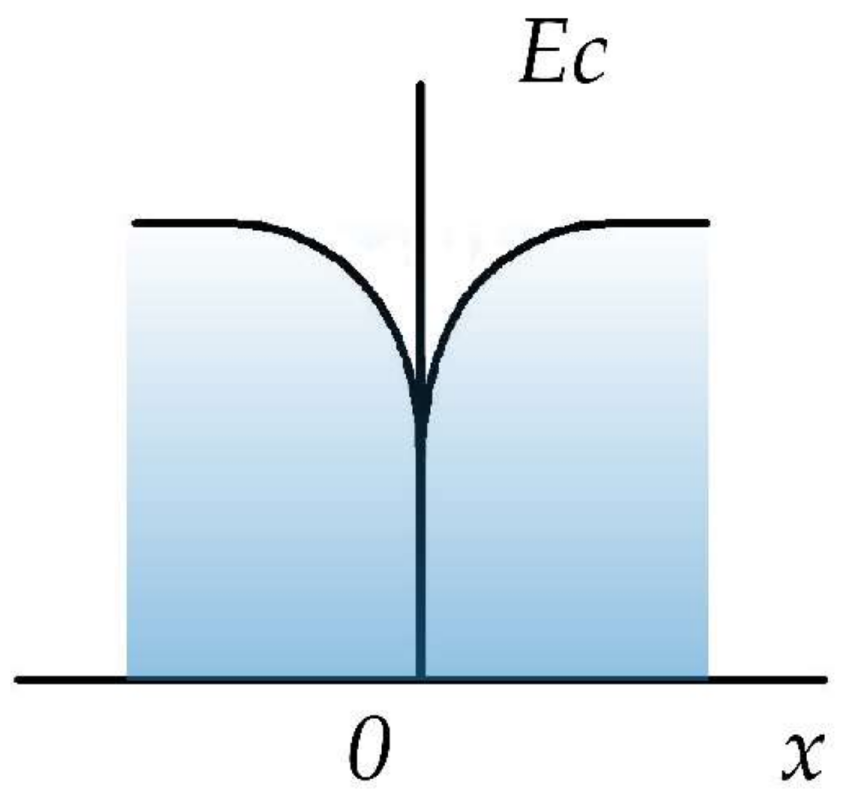
Figure 4. Dependence of conduction electrons potential energy in the powder particles on the x coordinate directed along the plane of their contact, x =